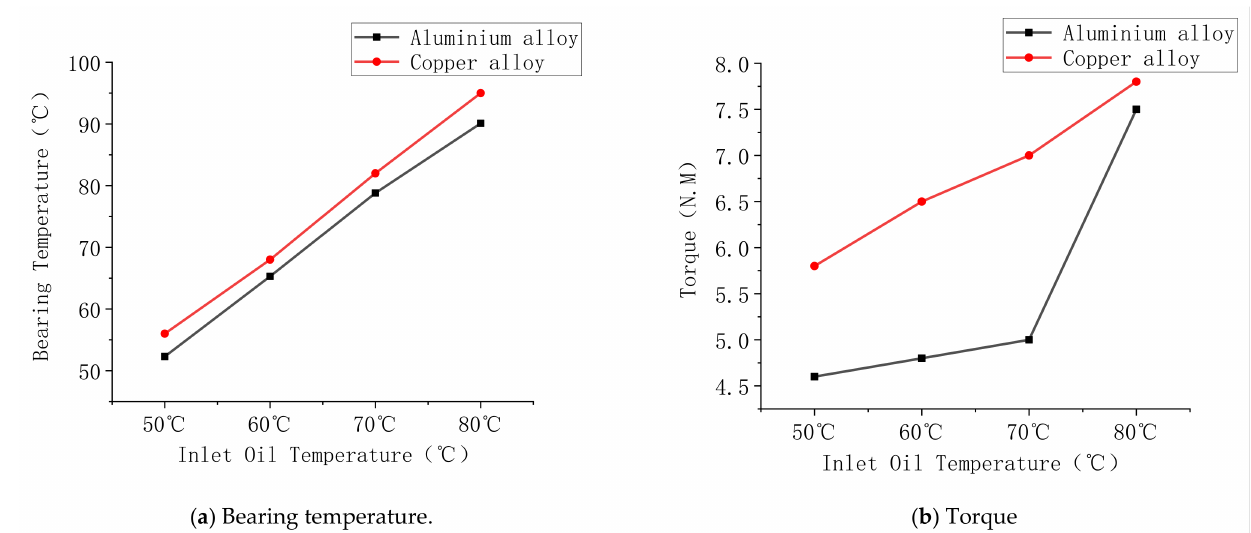
Figure 6. Comparison of bearing temperature and torque at different inlet oil temperatures.